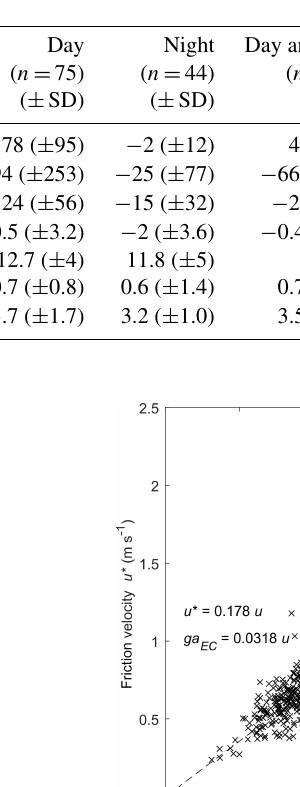
Table 4. Average micro-meteorological characteristics for half-hour periods with more than 0.25mm (30min) − 1 of P G for day (07:00—19:00UTC + 1) and night conditions (19:00–07:00UTC + 1).